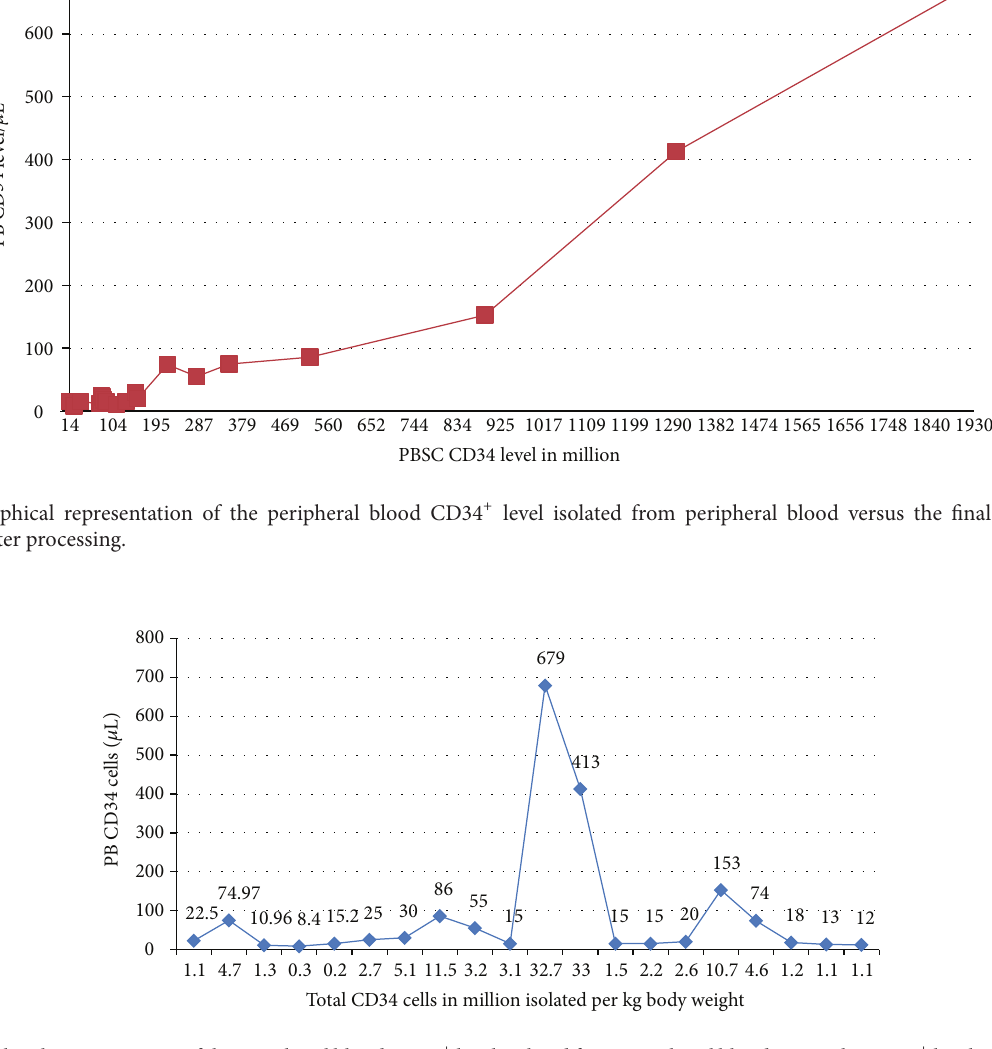
Figure 2: Graphical representation of the peripheral blood CD34 + level isolated from peripheral blood versus the CD34 + level enumerated/kg body